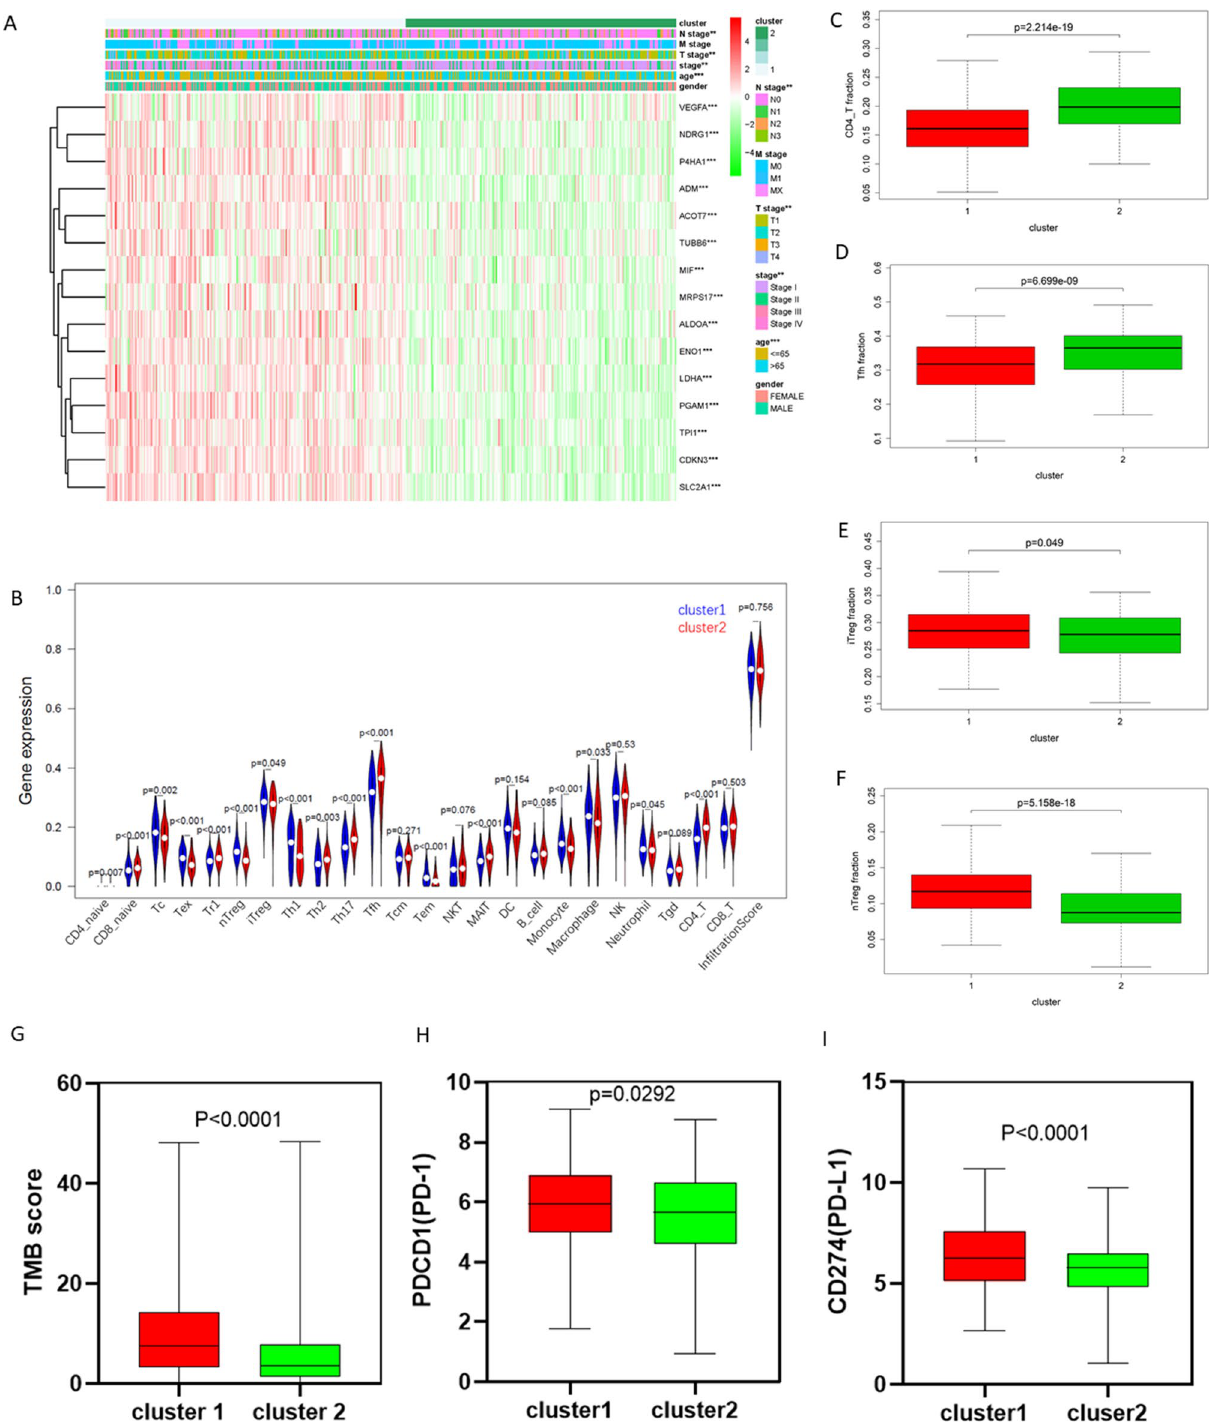
Figure 3. Immune cell infiltration and TMB score of different hypoxia status in LUAD. ( A ) The heatmap of clinicopathological characteristics in cluster 1 and cluster 2. ( B ) The violin plot of infiltration score and 24 immune cell types in cluster1 and cluster2 (Wilcox Test). ( C – F ) The infiltration of CD4+ T cell, Thf cell, iTreg cell, and nTreg cell in cluster1 and cluster2 (Wilcox Test). ( G ) The TMB score of cluster 1 and cluster 2. (H-I) The expression of PDCD1 (PD-1) and CD274 (PD-L1) in cluster 1 and cluster 2. *P < 0.05, **P < 0.01, and ***P <